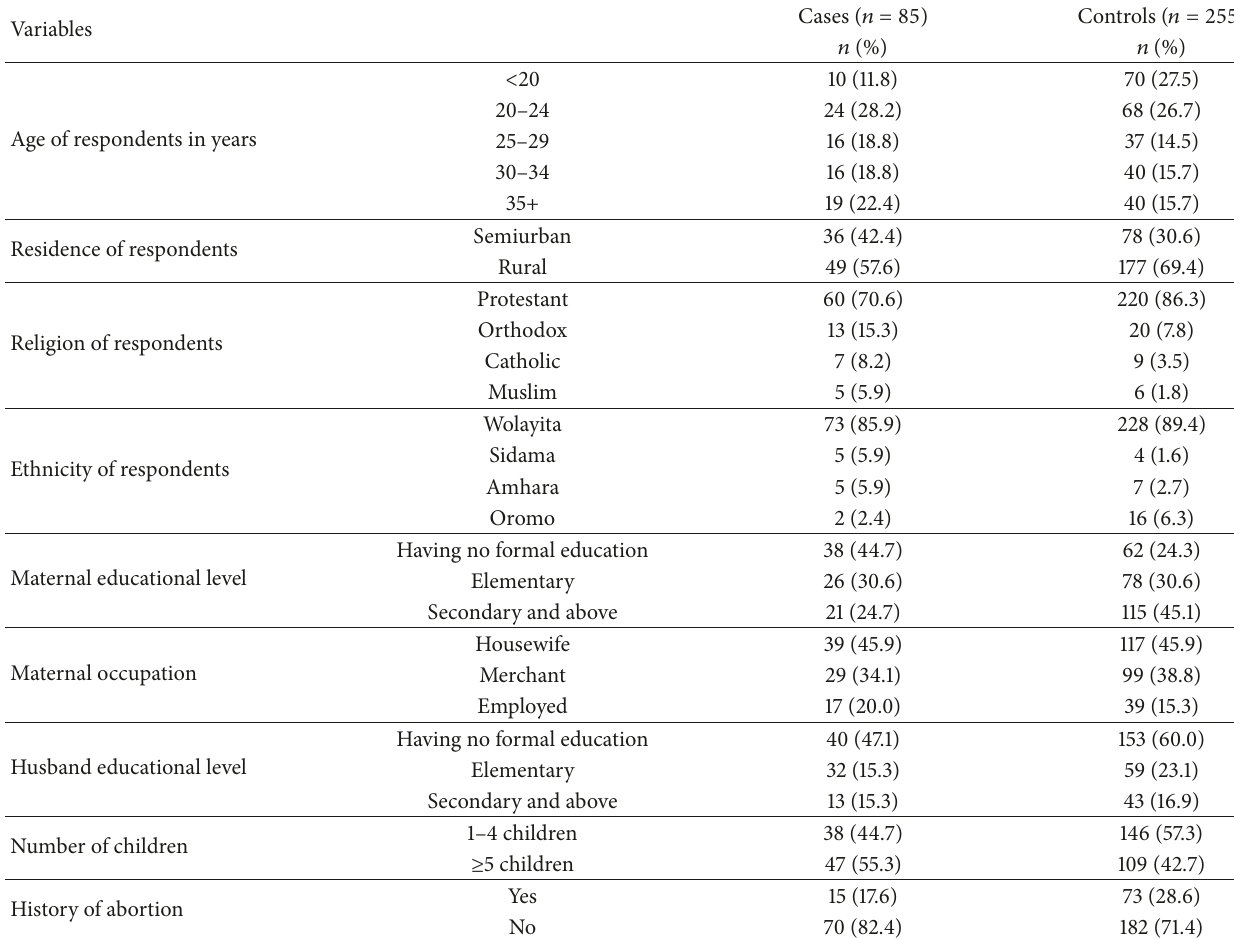
Table 1: Sociodemographic characteristics of study participants among women who ever used Implanon in Diguna Fang District, Wolayita Zone, Southern Ethiopia, March